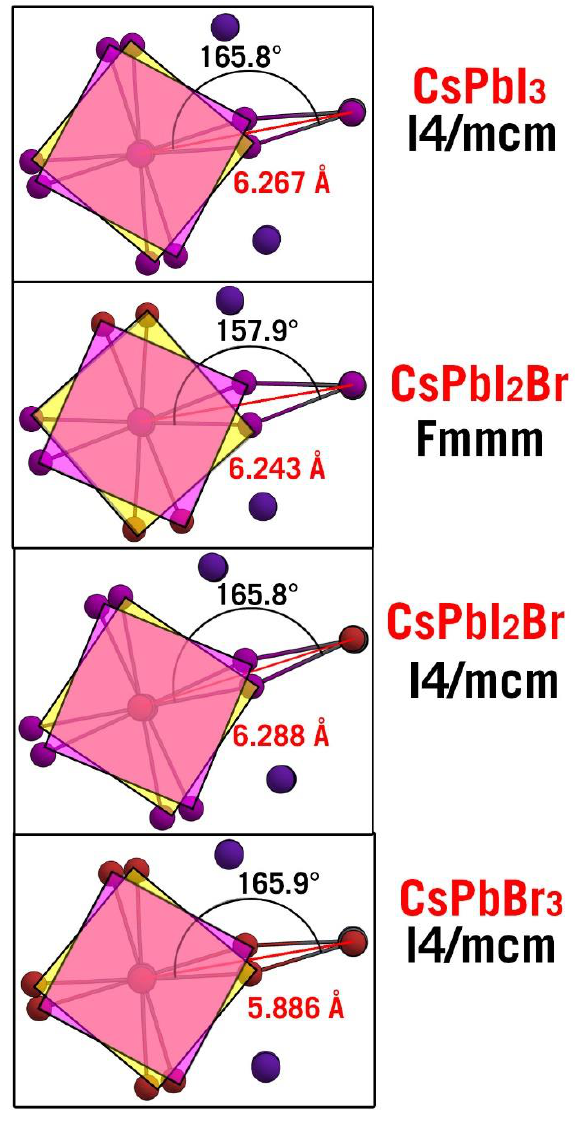
Figure 4. A view down the c-axis of the β phases of CsPbI 3 , CsPbI 2 Br ( I4/mcm and Fmmm ) and CsPbBr 3 . The colored squares indicate the equatorial planes of the PbX 6 octahedra for easier comparison.